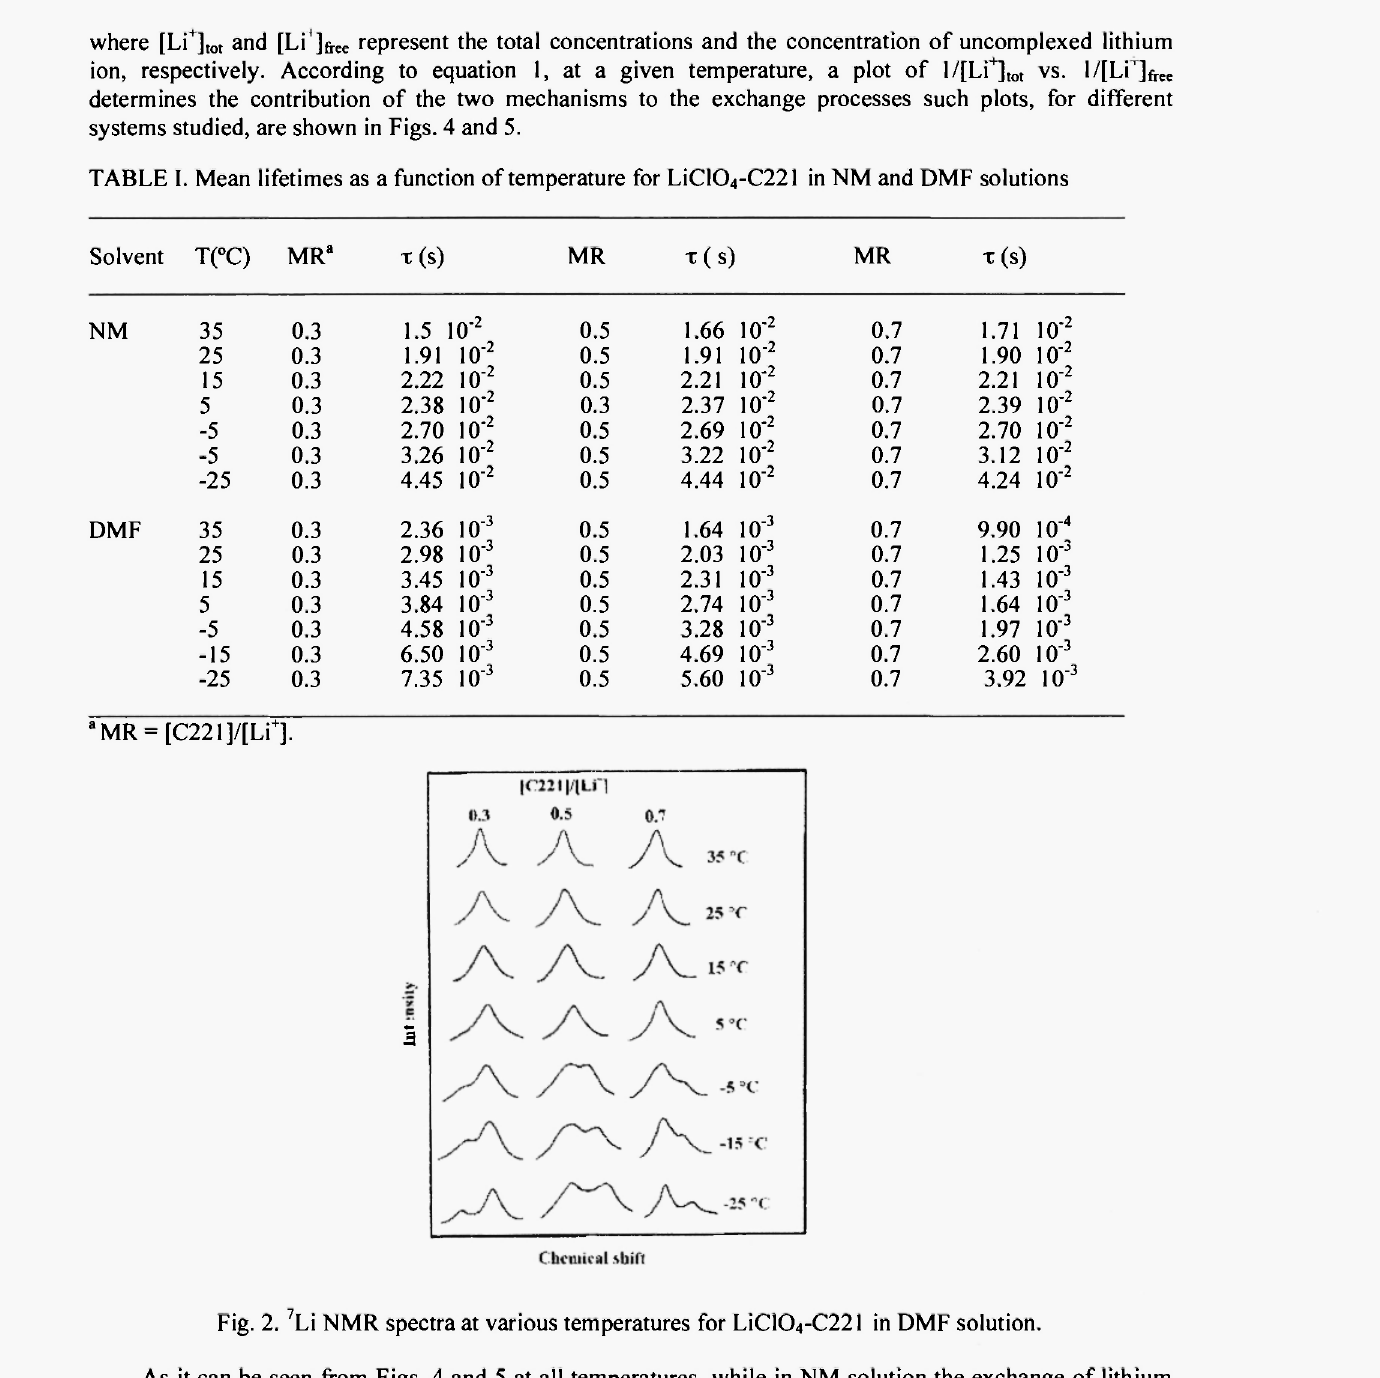
Fig. 2. 7 Li NMR spectra at various temperatures for LiC10 4 -C221 in DMF